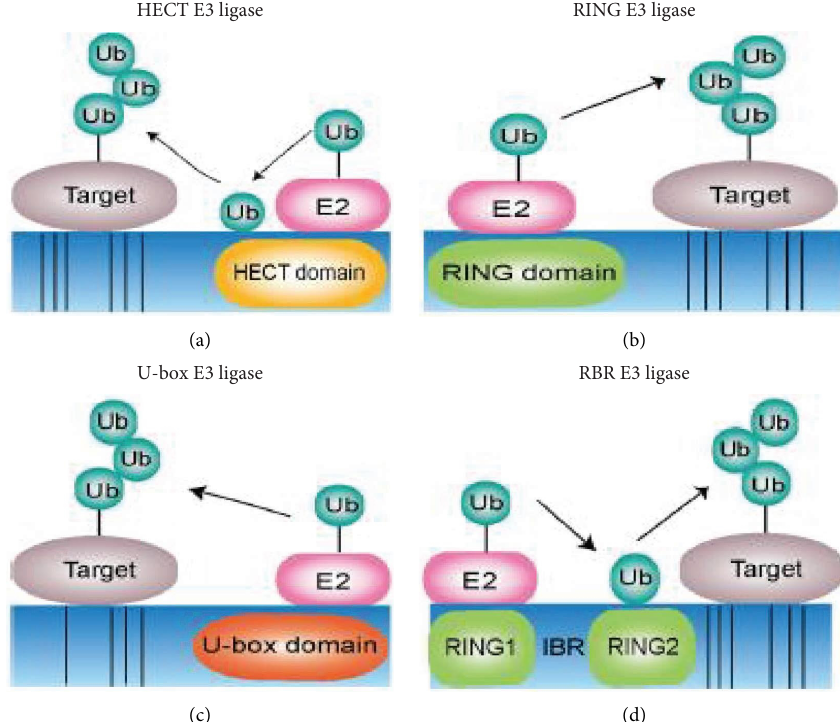
Figure 1: Types of ubiquitination ligases and ligase E3 function. (a) Te HECTtype of E3 ligases contains the conserved C-terminal HECT domain, and the N-terminal consists of diferent domains depending on the specifc subtype. HECT-type E3 ligases are involved in the ubiquitination process, which involves a two-step reaction: ubiquitin is frst carried out by an E2 ligase binding to the HECTdomain of the E3 ligase and then transferred to a catalytic cysteine on the E3 ligase; the second step is the transfer of ubiquitin from the E3 ligase to the substrate. (b) Te RING type E3 ligases are characterized by the presence of a zinc-binding domain called a RING at the N-terminal. Ring E3s mediate a direct transfer of ubiquitin from E2 ligase to the substrate. (c) Te U-box type E3 ligases contain a U-box domain at the C- terminal, which is responsible for binding the ubiquitin-charged E2 ligase and stimulating ubiquitin transfer. (d) Te RBR type E3 ligases consist of two predicted RING domains (RING1 and RING2) separated by an IBR domain. RBR type E3 ligases’ catalyzed ubiquitination process involves a two-step reaction where ubiquitin is frst transferred to a catalytic RING2 domain on the E3 and then to the substrate